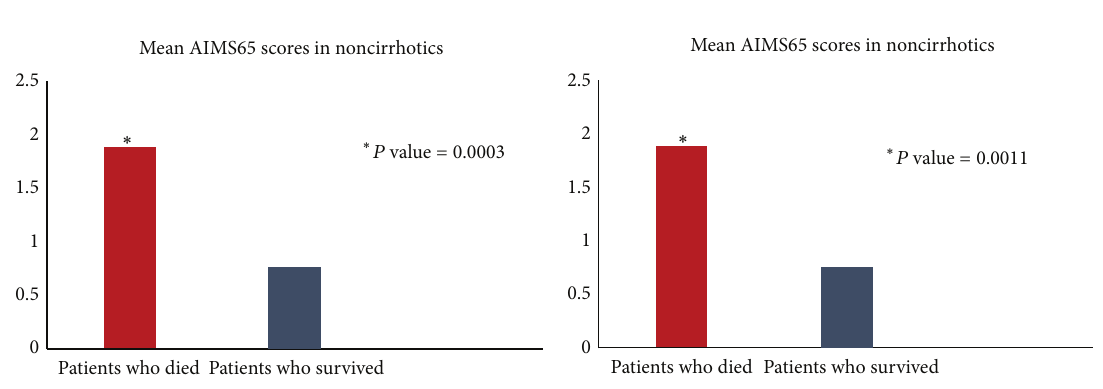
Figure 9: Mean AIMS65 scores were significantly higher in patients who died than in patients who survived, in both noncirrhotic and cirrhotic